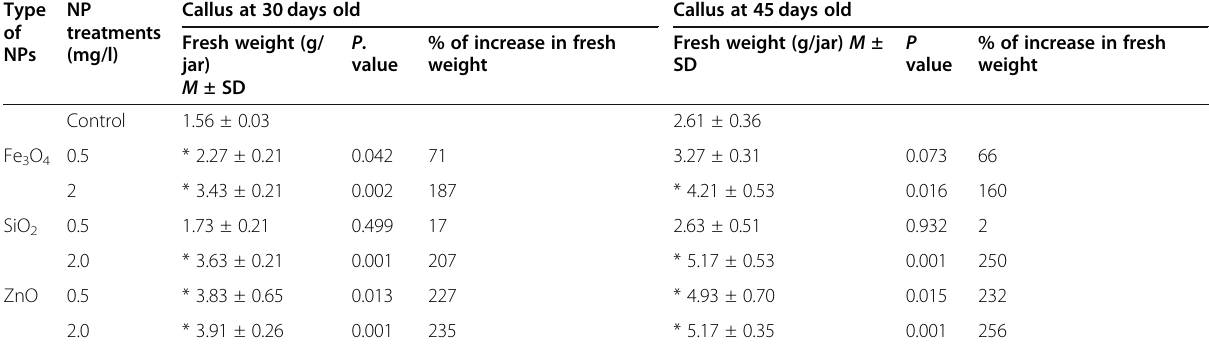
Table 1 Effect of nanoparticles on fresh weight of Salvadora persica callus after 30 and 45 days of treatment Type of NPs